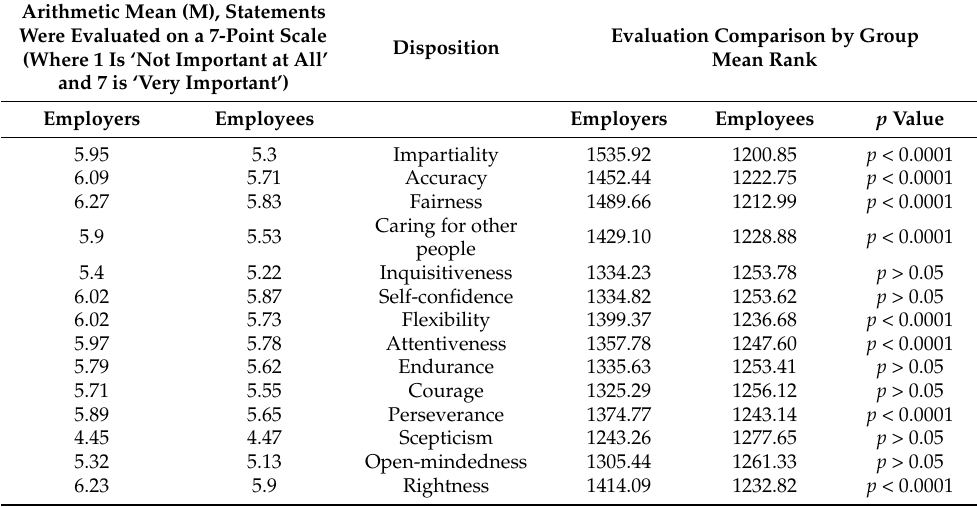
Table 3. Evaluation of the importance of critical thinking dispositions in the modern labour mar- ket/evaluation comparison by